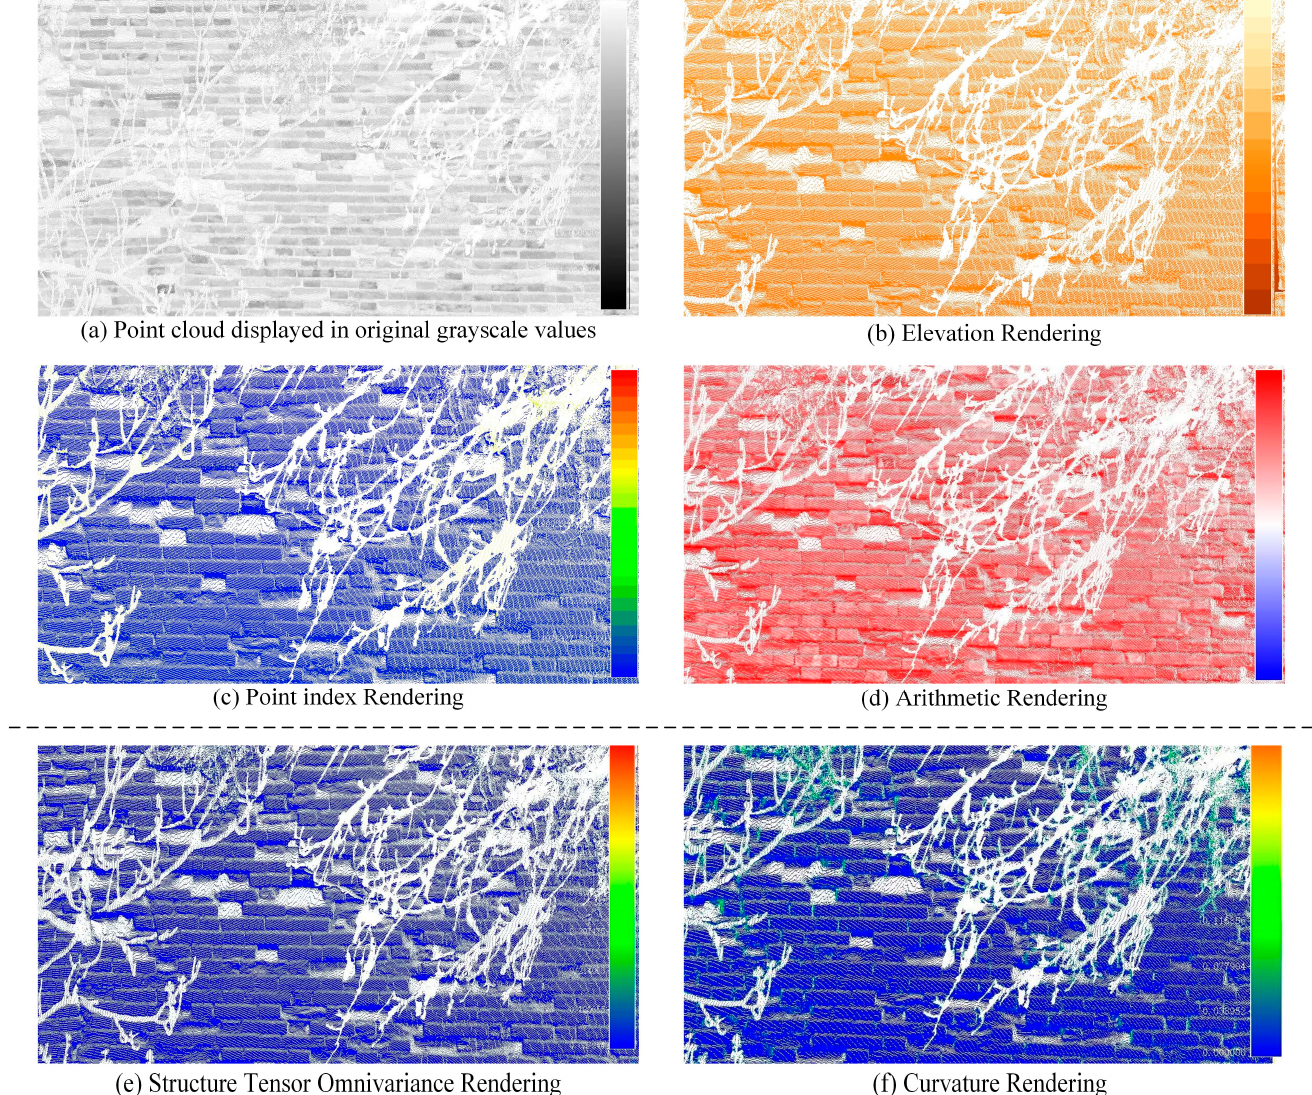
Figure 29. Part of the wall point cloud displayed in the original grayscale value. Figure 29a shows the city wall point cloud displayed in original gray scale values.